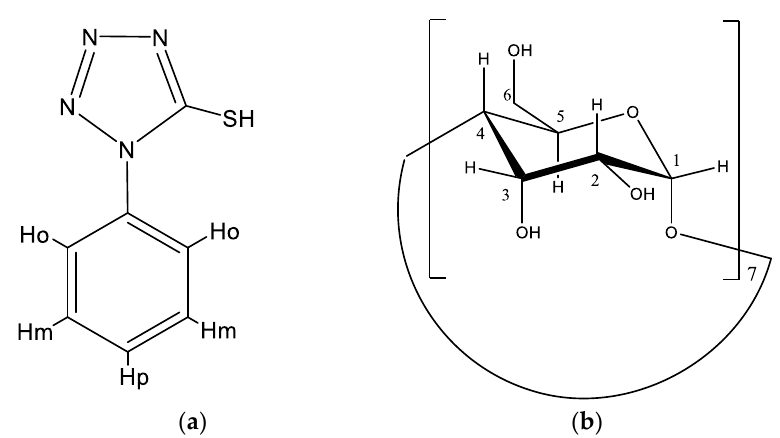
Figure 1. Molecular structure of ( a ) 5-mercapto-1-phenyl-tetrazole (MPT) and ( b ) β-cyclodextrin (β–CD). β–CD is a CD type constituted by 7 glucopyranoside units linked by 1,4 glycosydic bonds.